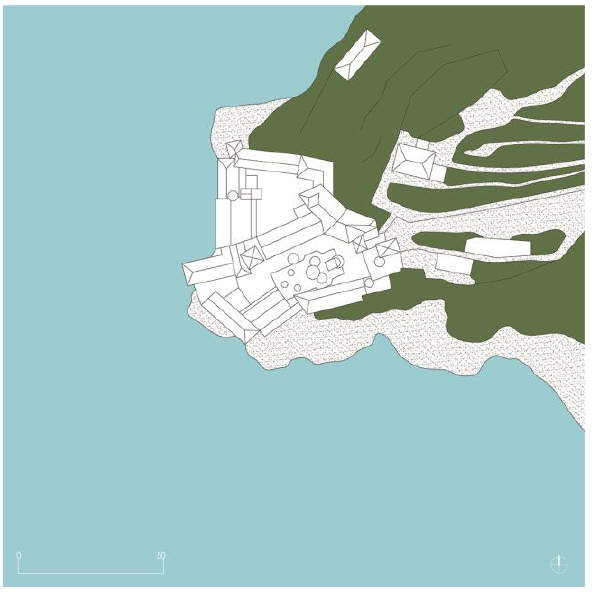
Figure 23 . The Monastery of St. Pantaleimon. General plan.